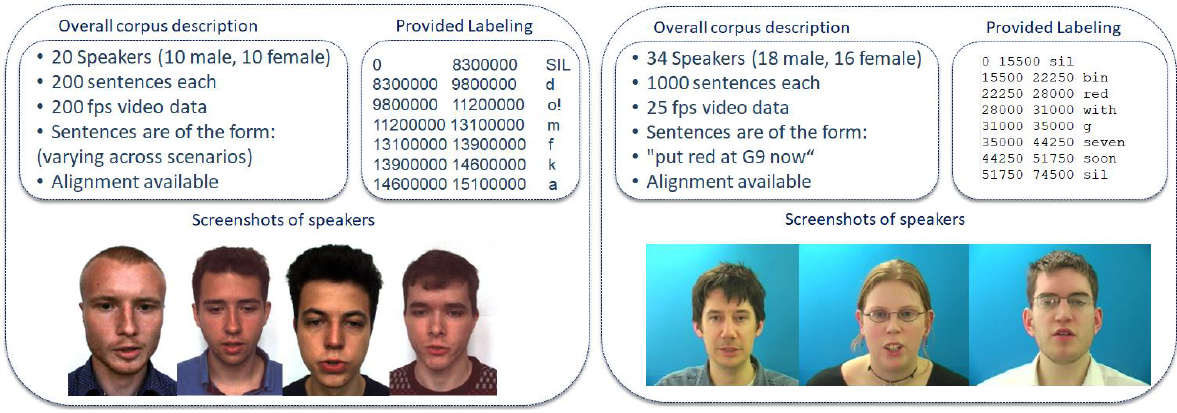
Figure 1 – HAVRUS (left) and GRID (right) visual speech datasets